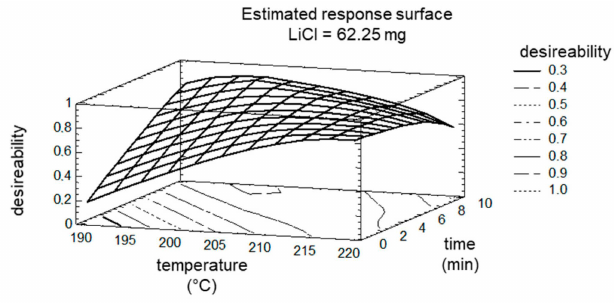
Figure 8. Estimated Response Surface; the factor LiCl is fixed at 65.25 mg.